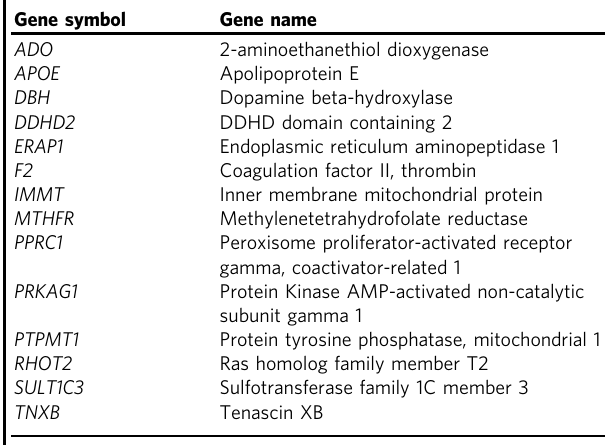
Table 1 Metabolism-related genes containing common amino acid sequence variations that are associated with human blood pressure a